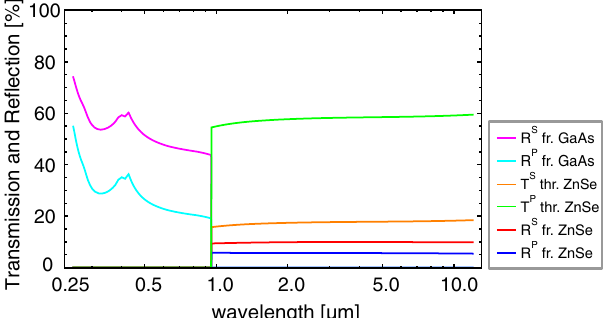
FIG. 5. Input beam transmission and reflection for the GaAs and ZnSe beam splitters. GaAs, with a sharp transmission edge at around 900 nm and low-bulk absorption of ≤ 0 . 01 cm − 1 @ 10 . 6 μ m, is ideal for a spectral separation of the UV-NIR range from the near to the MIR range. ZnSe reflects on average 7% of the beam and transmits 18% and 60% of the input beam for s- and p-polarization, respectively.